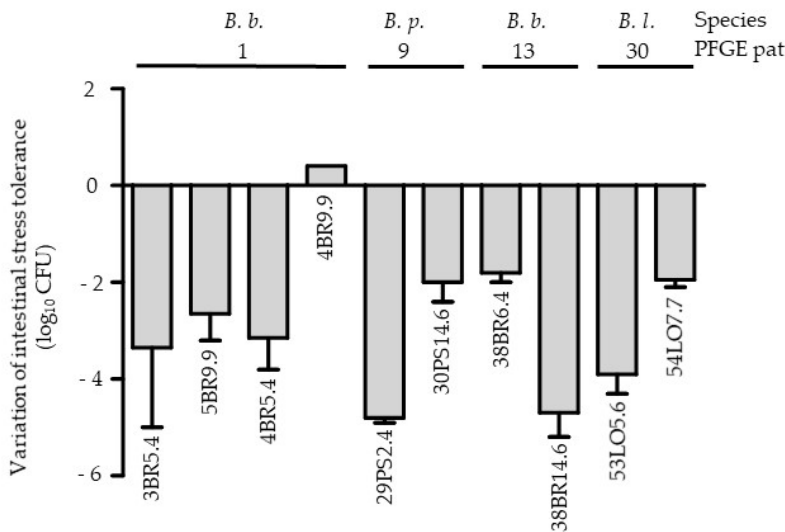
Figure 2. Comparison of the intestinal stress tolerance of bifidobacteria strains with same PFGE pattern. B. b. : B. breve , B. p .: B. pseudocatenulatum , B. l. : B. longum subsp. longum . The names of the strains are shown below each histogram. The errors bars represent the SEM deviation obtained with two independent experiments.